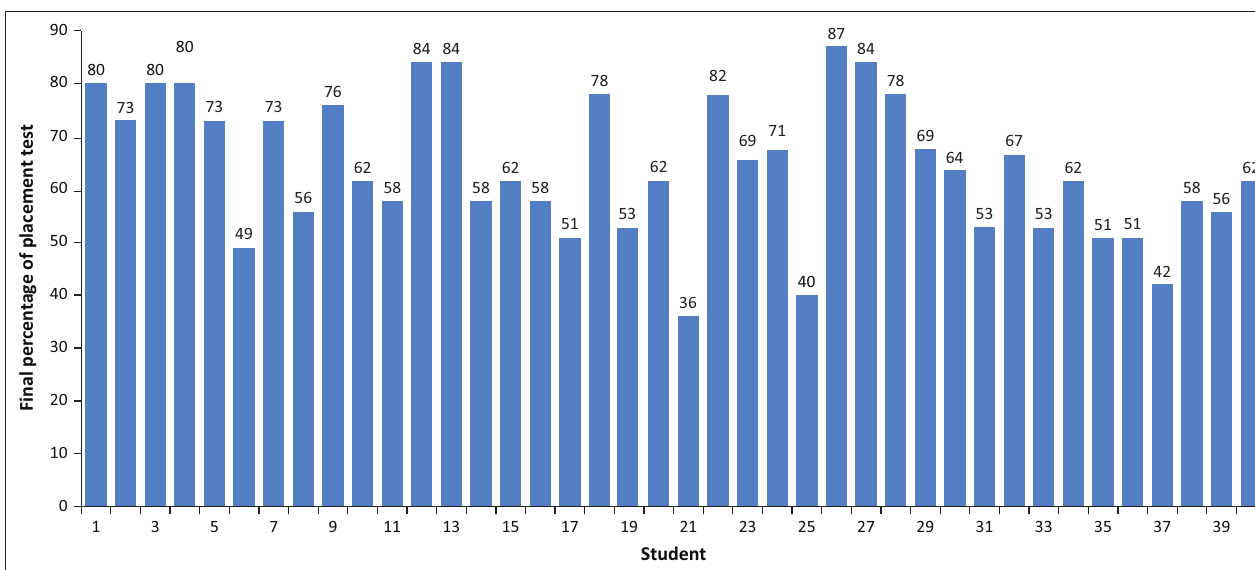
FIGURE 7: Placement test results for direct English distance learning (EDL) students.